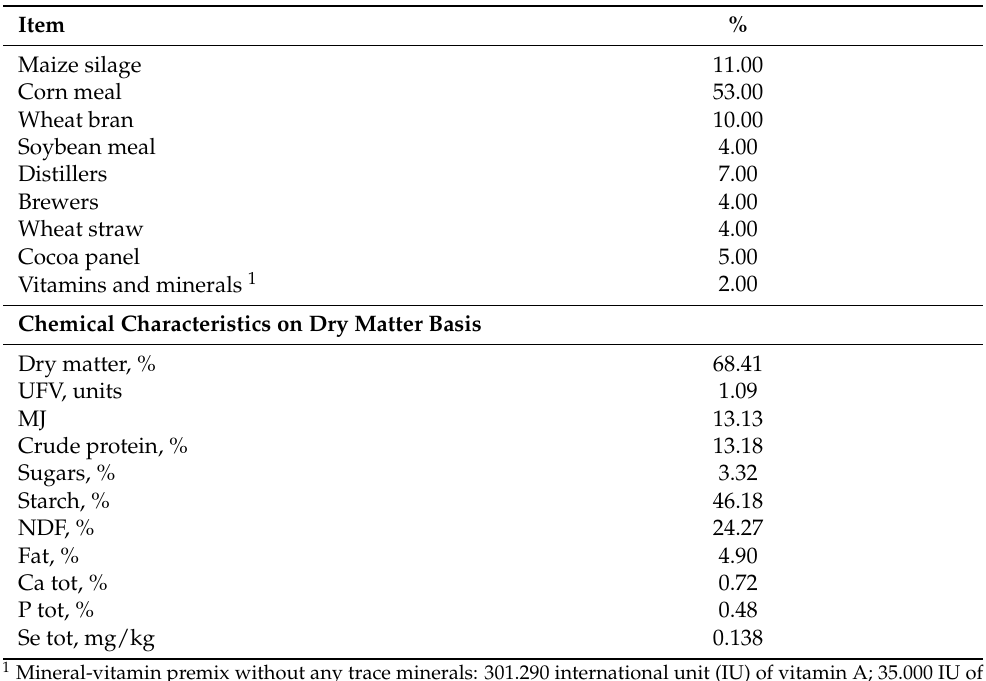
Table 1. Composition of the diets on a dry matter basis